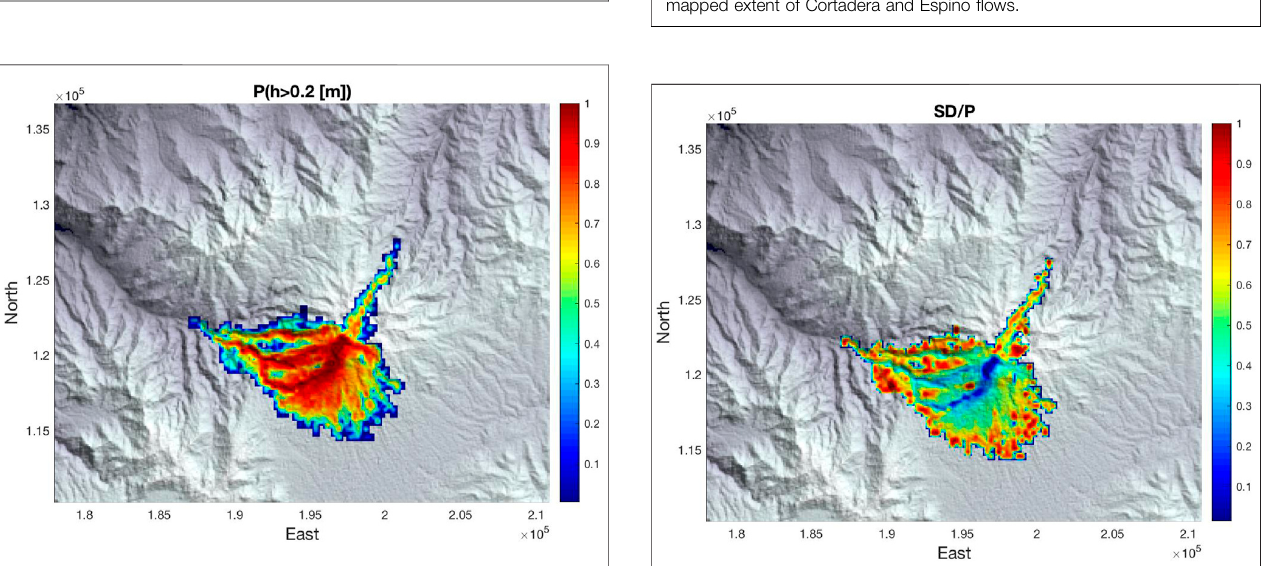
FIGURE 11 | Titan2D estimate of non-con fi dence in emulator based probability assessment for Scenario 2, using the ratio of standard deviation and probability. Lower SD/P is better, showing that near vent, con fi dence in model output is